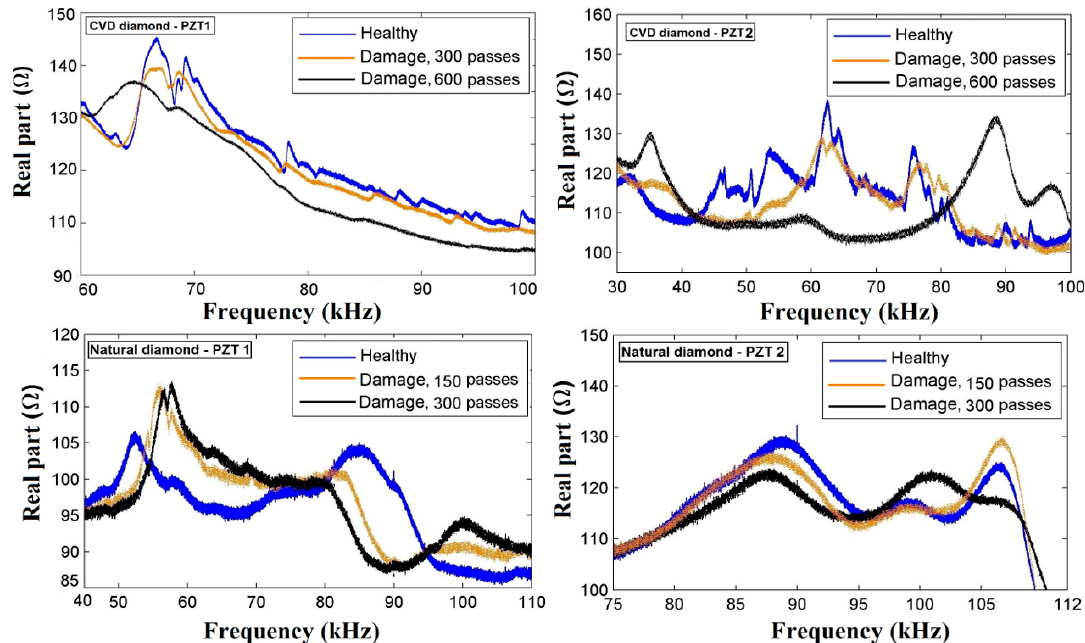
Figure 5. Impedance signatures for both PZT1 and PZT2 diaphragms obtained for the diamond-dressing tools under the healthy and damaged conditions. tools under the healthy and damaged